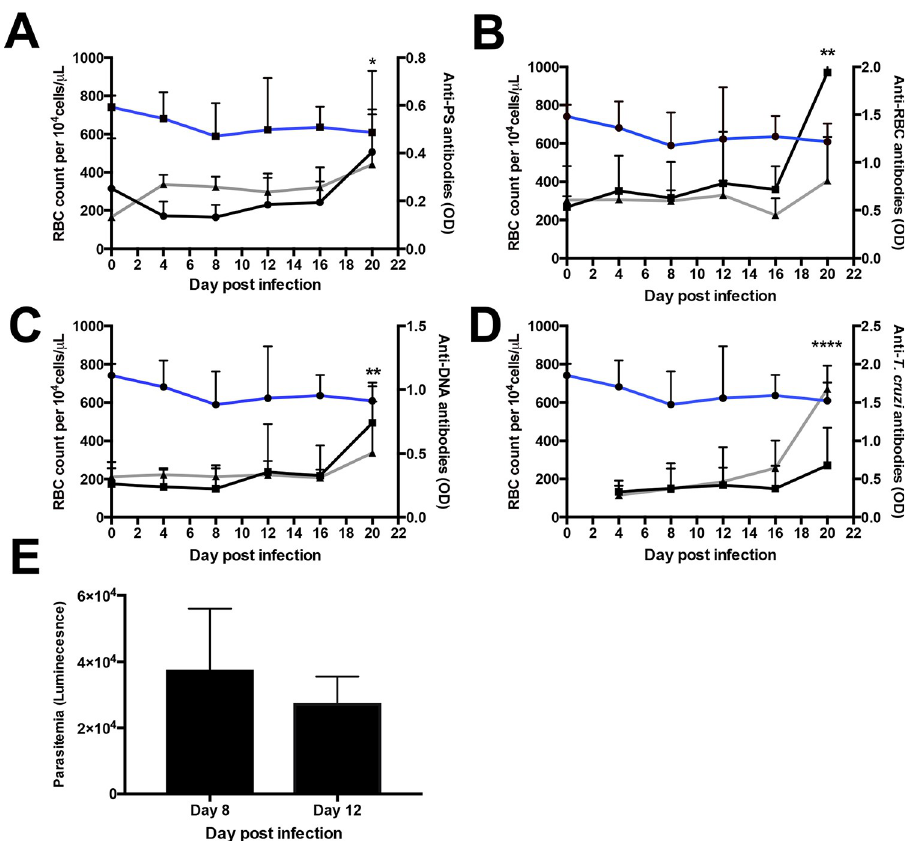
Fig 3. Antibodies and anemia during acute T . cruzi infection in mice. Longitudinal analysis of erythrocyte count (blue line), IgM (black line) and IgG (grey line) autoantibodies (a-c) or anti- T . cruzi IgG antibodies (d) in T . cruzi- infected mice. (e) Bar graph with average parasitemia of mice infected with T . cruzi . Line and bar graphs represent the means ± SD of n = 3–6 mice per time point from two independent experiments. Significance between erythrocyte counts or levels of antibodies at any day post-infection compared to day 4 was determined by one-way ANOVA. � p < 0.05, �� p < 0.01, ���� p < 0.0001.